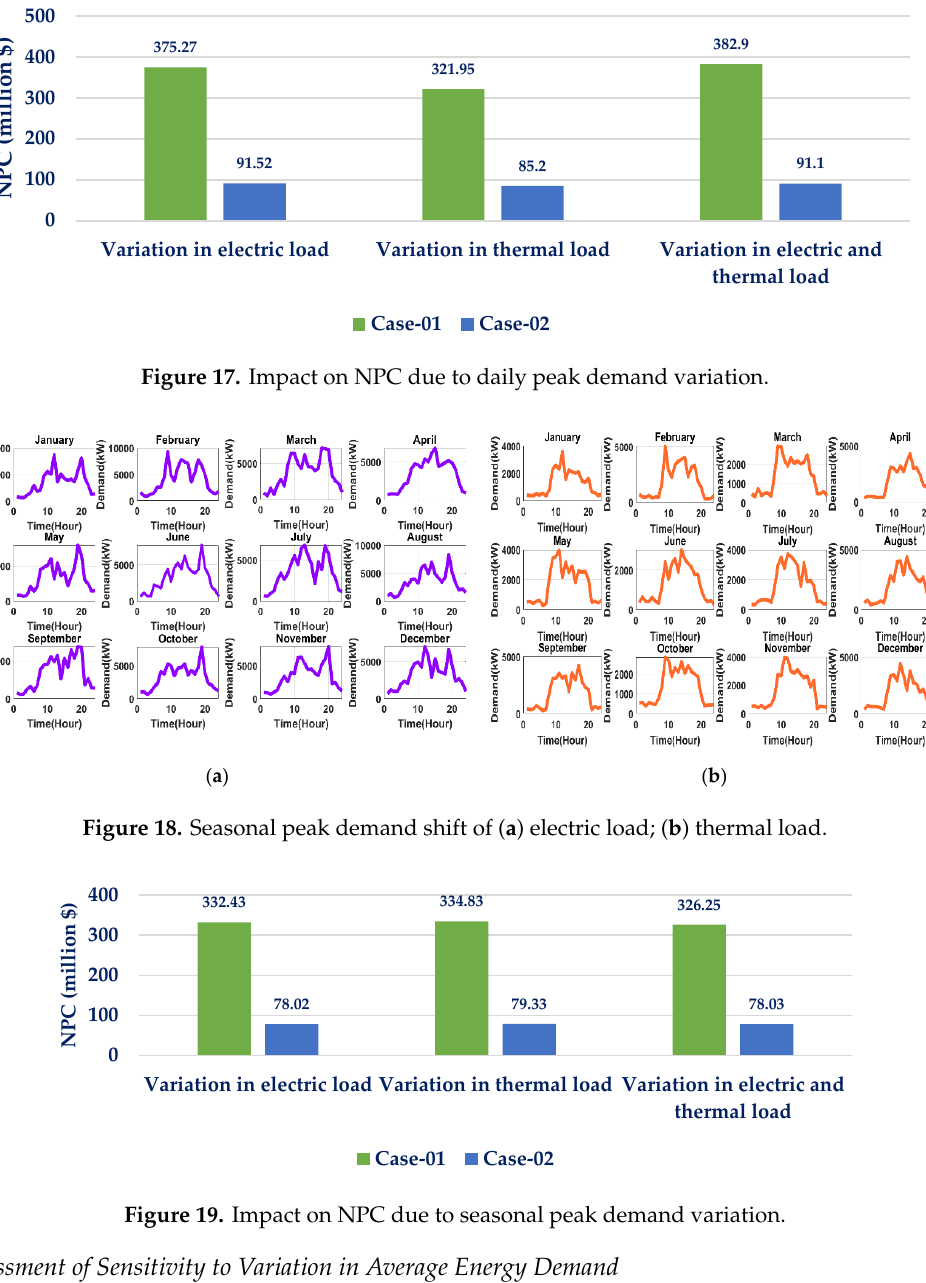
Figure 19. Impact on NPC due to seasonal peak demand variation.